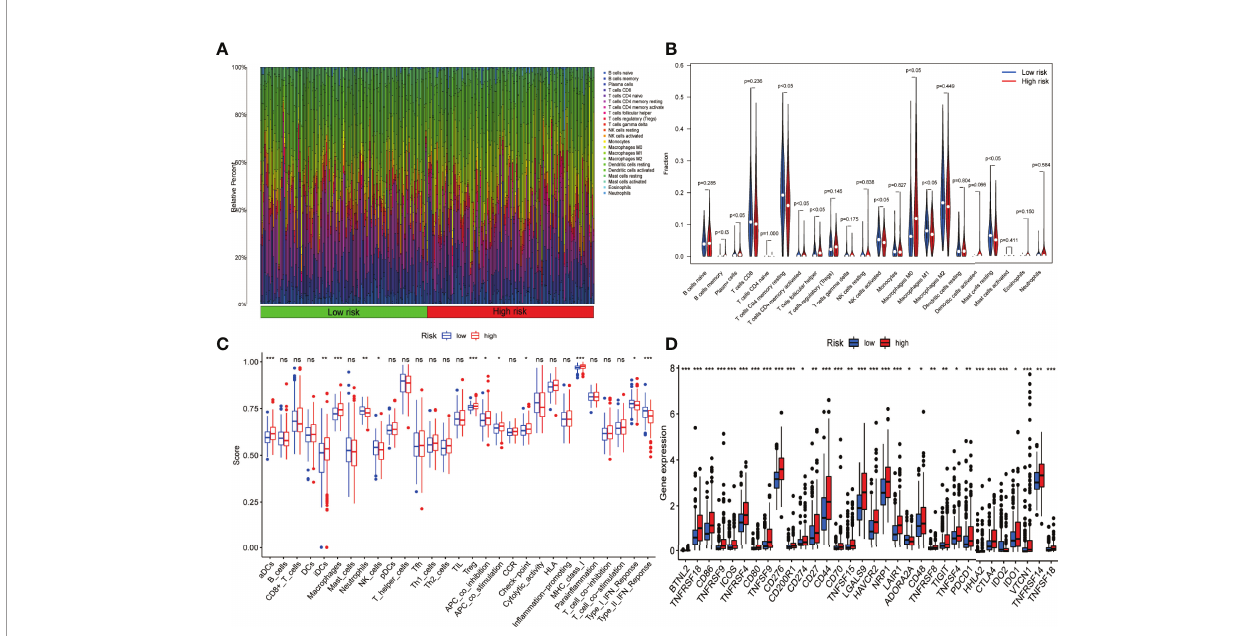
FIGURE 9 | Presentation of the expression pro fi le of immune checkpoints genes and Immune cell in fi ltration among low-risk and high-risk groups. (A) Barplot depicting the 22 immune in fi ltrating cell proportions of the high-risk and low-risk. (B) The differential proportion of the immune cells has been calculated via violin plot among low-risk and high-risk patients. (C) Boxplots depict the 29-immune signature ssGSEA scores of high-risk patients compared to low-risk patients. (D) Comparative analysis among the high- and low-risk categories on the basis of the expression pro fi le of immune checkpoint genes (ns, no signi fi cance; *P < 0.05; **P < 0.01; ***P <